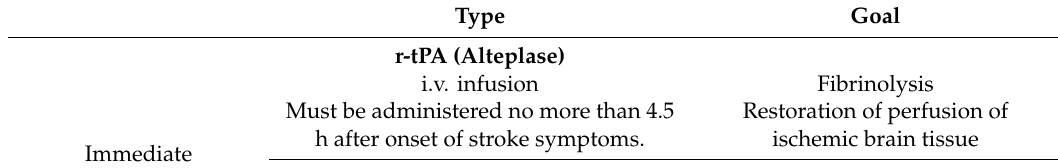
Table 1. Strategies for treatment and prevention of ischemic stroke. Immediate (i.e., emergent) interventions for ischemic stroke include recombinant tissue plasminogen activator (r-tPA) infusion and endovascular thrombectomy (EVT). In addition to these approaches, preventative measures can be instituted for patients at high risk for stroke or to prevent recurrent stroke. Rehabilitative strategies are utilized to facilitate post-stroke recovery and to reduce the risk of recurrent ischemic